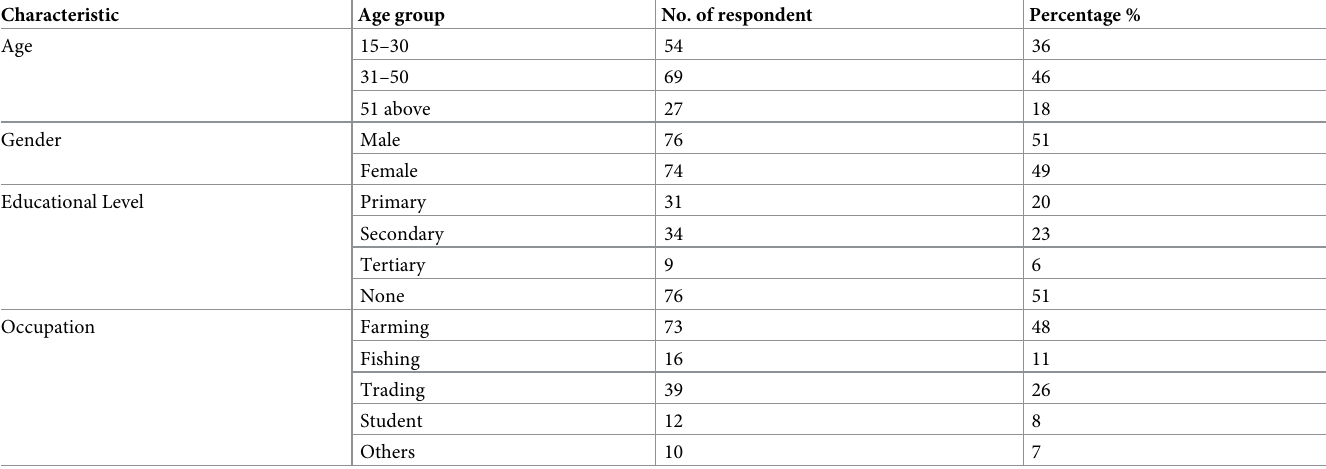
Table 1. Demographic data of respondents of the community.